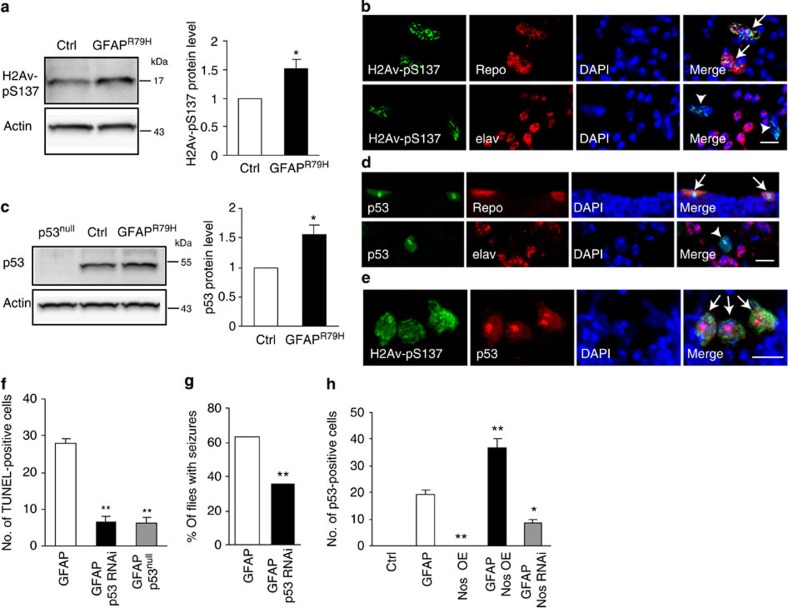
Activation of the DNA damage response and p53 in GFAP transgenic flies.(a,c) Western blots show significantly increased H2Av-pSer137 and p53 levels in GFAPR79H transgenic flies. The blots were reprobed for actin to illustrate equivalent loading. *P=0.0290, t=3.034, df=5, n=6 (a); *P=0.0356, t=3.118, df=4, n=5 (c); unpaired t-test. Ctrl: repo-GAL4/+. GFAPR79H: repo-GAL4, UAS-GFAPR79H/+. (b,d) H2Av-pS137 and p53 colocalize with the glial cell marker Repo (top panels, arrows) but not with the neuronal cell marker elav (bottom panels, arrowheads) in GFAPR79H transgenic flies. 4,6-Diamidino-2-phenylindole (DAPI) shows nuclei. Scale bar, 5 μm. Genotype: repo-GAL4, UAS-GFAPR79H/+. (e) Double-label immunofluorescence reveals colocalization of H2Av-pS137 and p53 in GFAPR79H transgenic flies (arrows). DAPI labels nuclei. Scale bar, 5 μm. Genotype: repo-GAL4, UAS-GFAPR79H/+. (f) Knocking down or removing p53 with transgenic RNAi or a p53null allele decreases the number of TUNEL-positive cells in GFAPR79H transgenic flies. **P<0.0001, F=74.69, df=18; one-way ANOVA, n⩾6 per genotype. Genotypes are indicated in the figure label. Driver: repo-GAL4. (g) Seizure frequency is decreased with reduced expression of p53 (p53 RNAi). **P<0.0001, χ2=45.671, df=1; χ2-test, n>100 per genotype. Genotypes are indicated in the figure label. Driver: repo-GAL4. (h) Overexpression of Nos (GFAP Nos OE) increases, while reducing Nos (GFAP Nos RNAi) decreases the number of p53-positive cells in GFAP transgenic flies. No p53 accumulation is present in Ctrl and Nos OE alone. *P<0.01, **P<0.0001, F=69.03, df=30; one-way ANOVA, n⩾6 per genotype. Genotypes are indicated in the figure label. Driver: repo-GAL4. Ctrl: repo-GAL4/+. Flies were 1 day old in g and 20 days old in other panels.